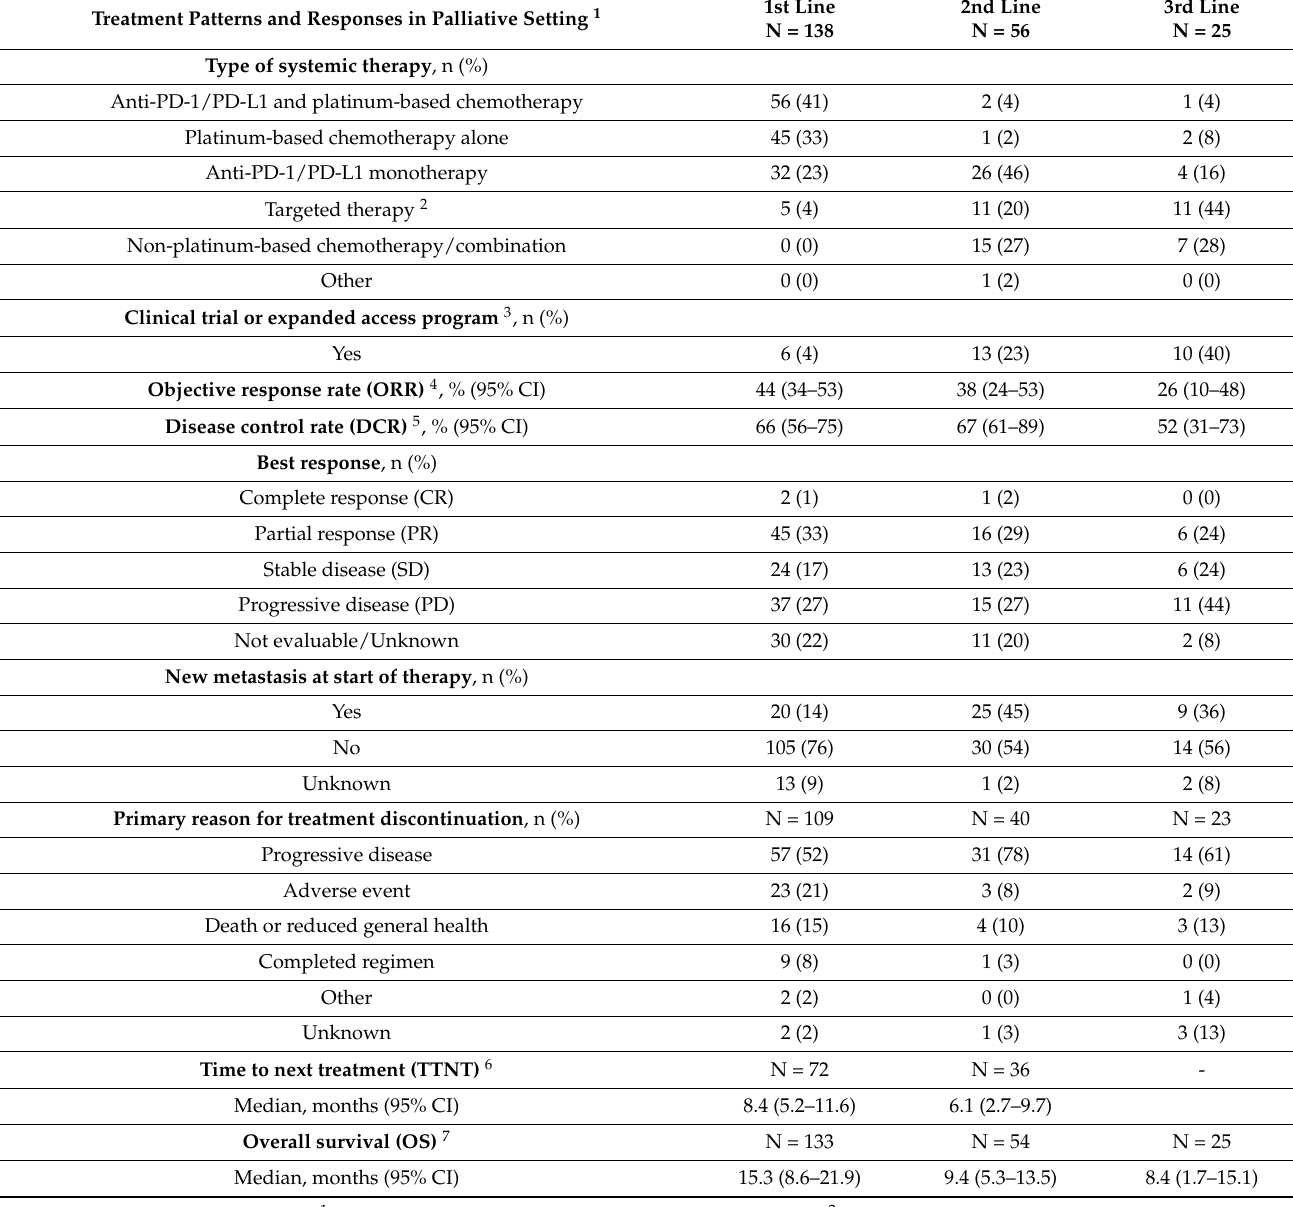
Table 4. Treatment patterns and